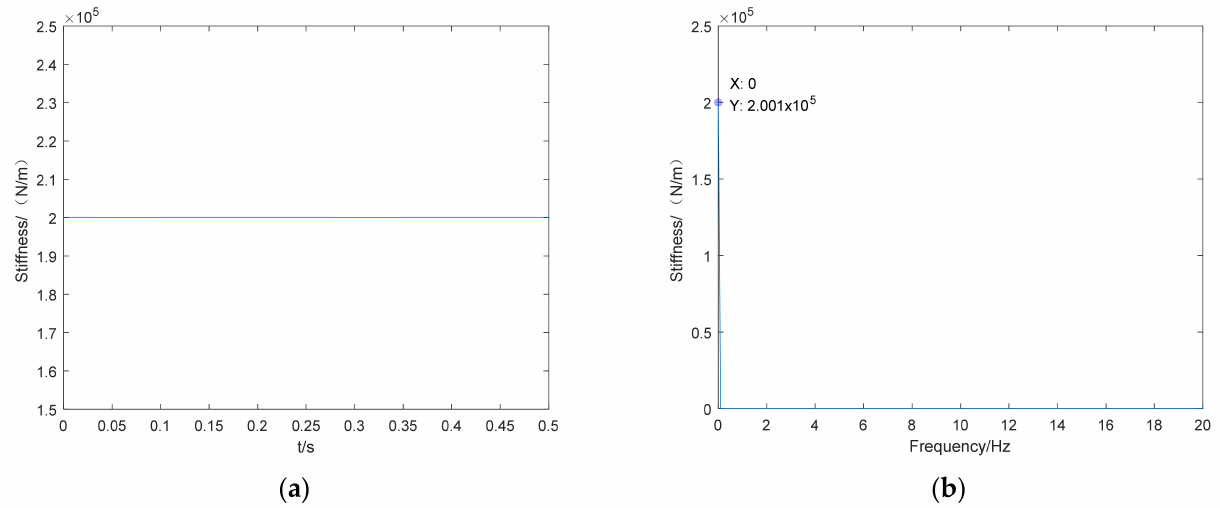
Figure 5. Time domain identification result ( a ) and frequency domain identification results ( b ) of non-time-varying stiffness k ∗ . 2